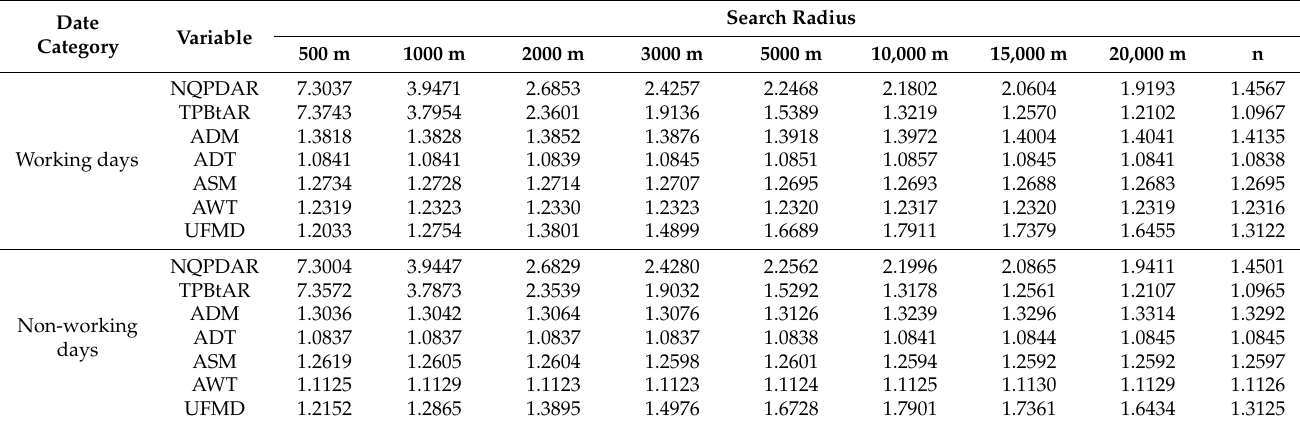
Table 4. The VIF of explanatory variables.